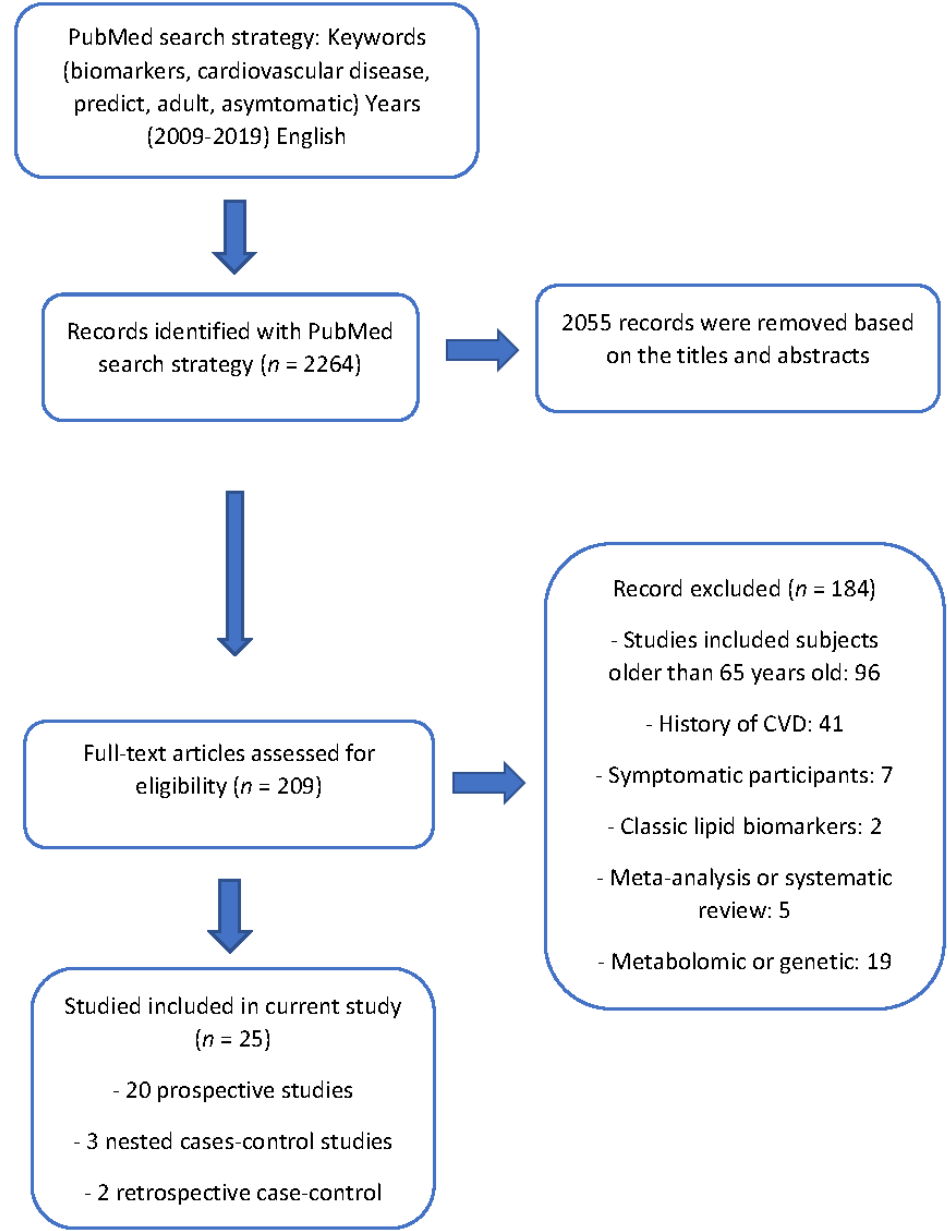
Figure 1. Flow diagram illustrating the search strategy used according to PRISMA (Preferred Reporting Items for Systematic Reviews and Meta-Analyses) statement.